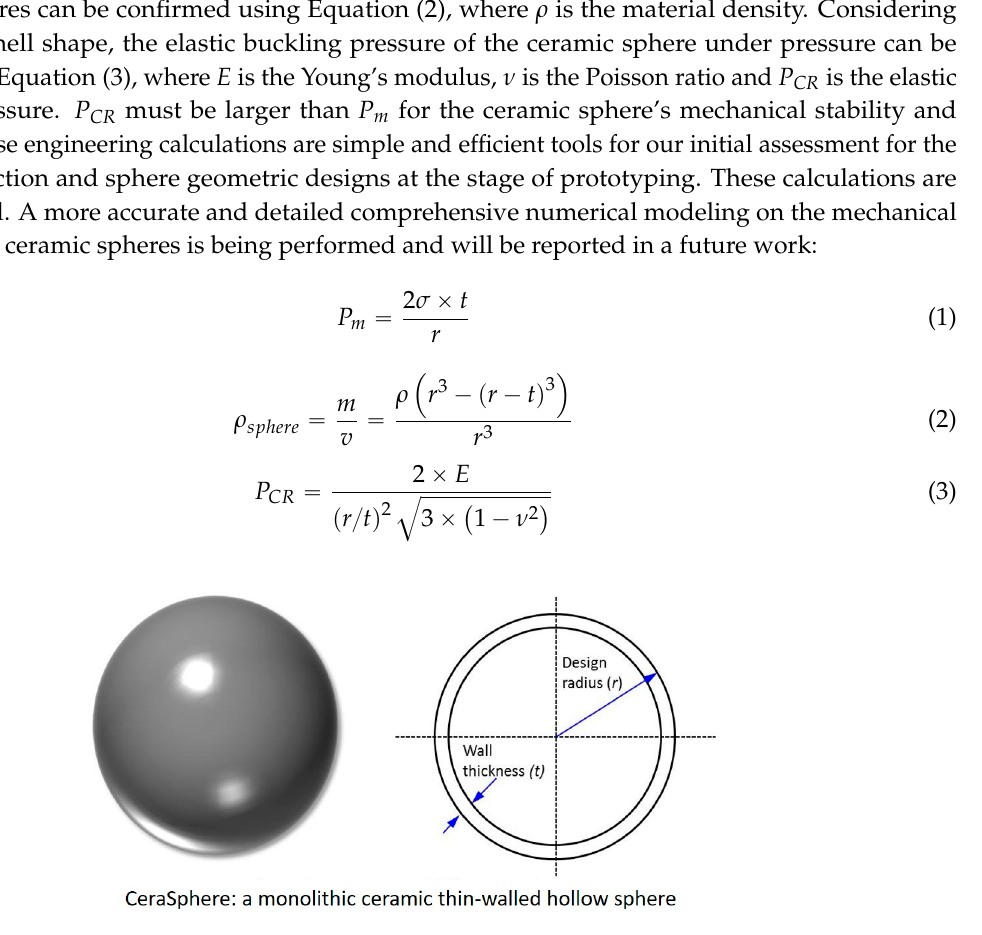
Figure 1. A concept schematic of the ceramic sphere.